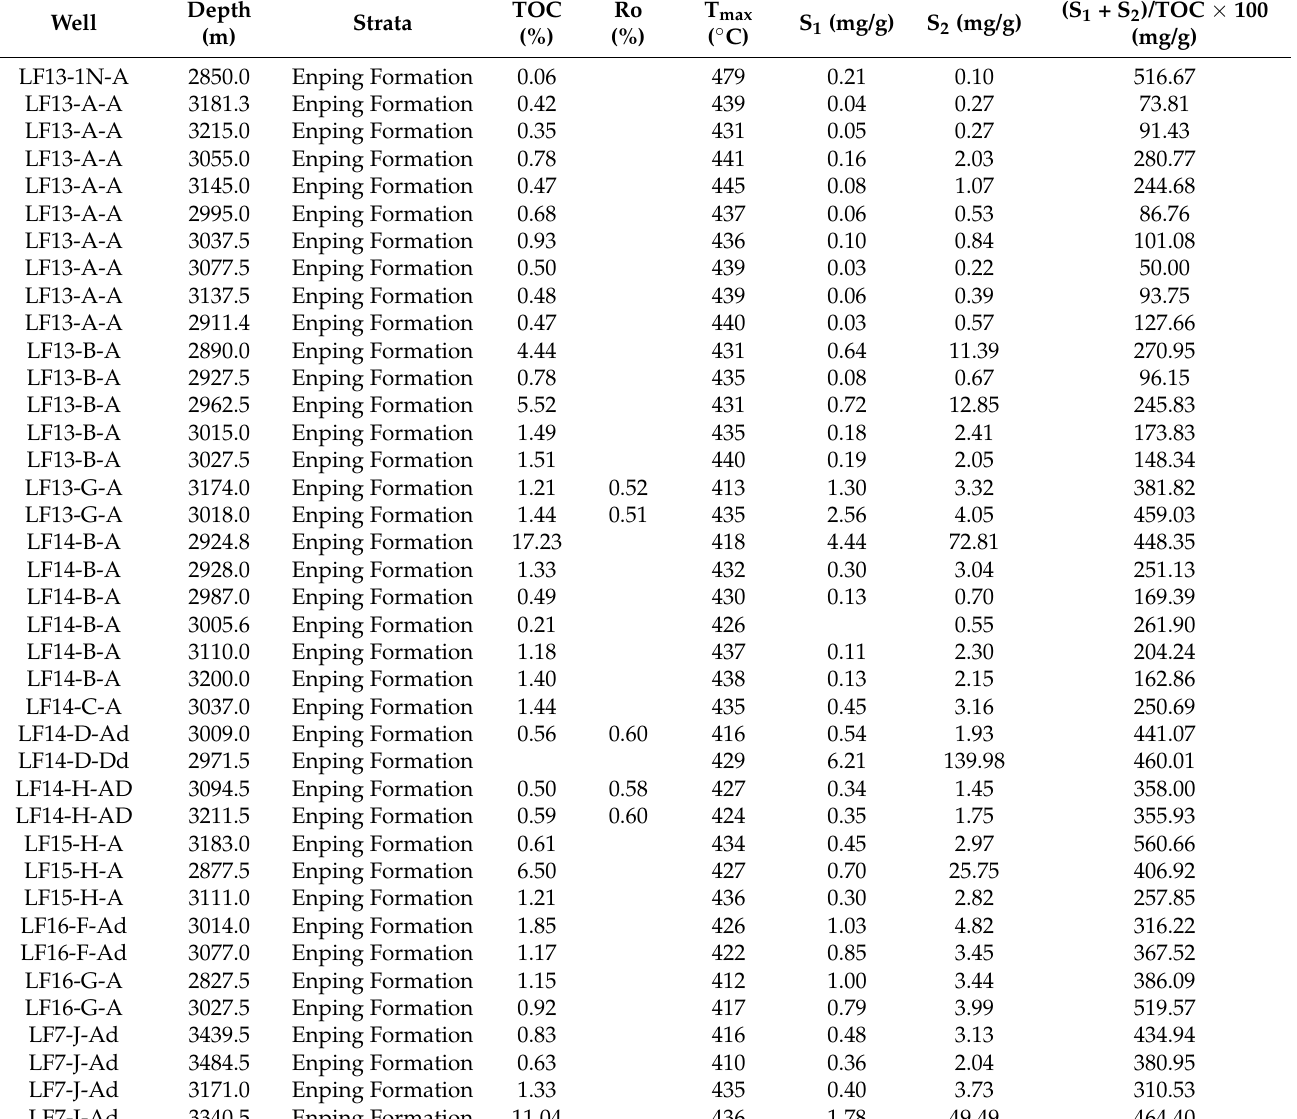
Table A1. Calculation table of organic geochemical data and hydrocarbon generation potential index of Paleogene source rocks in southern Lufeng